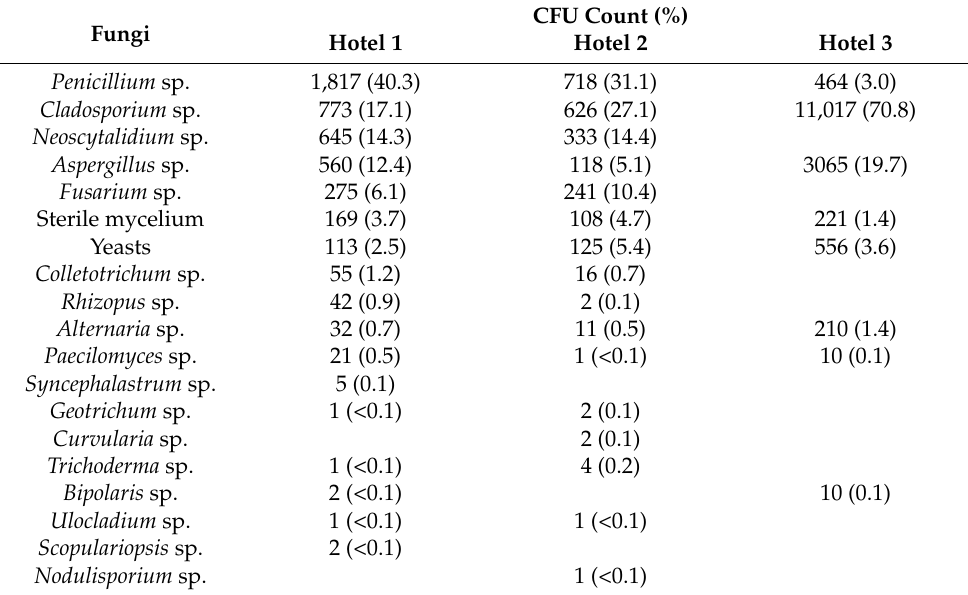
Table 2. Total CFU count (per m 3 of air) by genus and their proportional concentration.